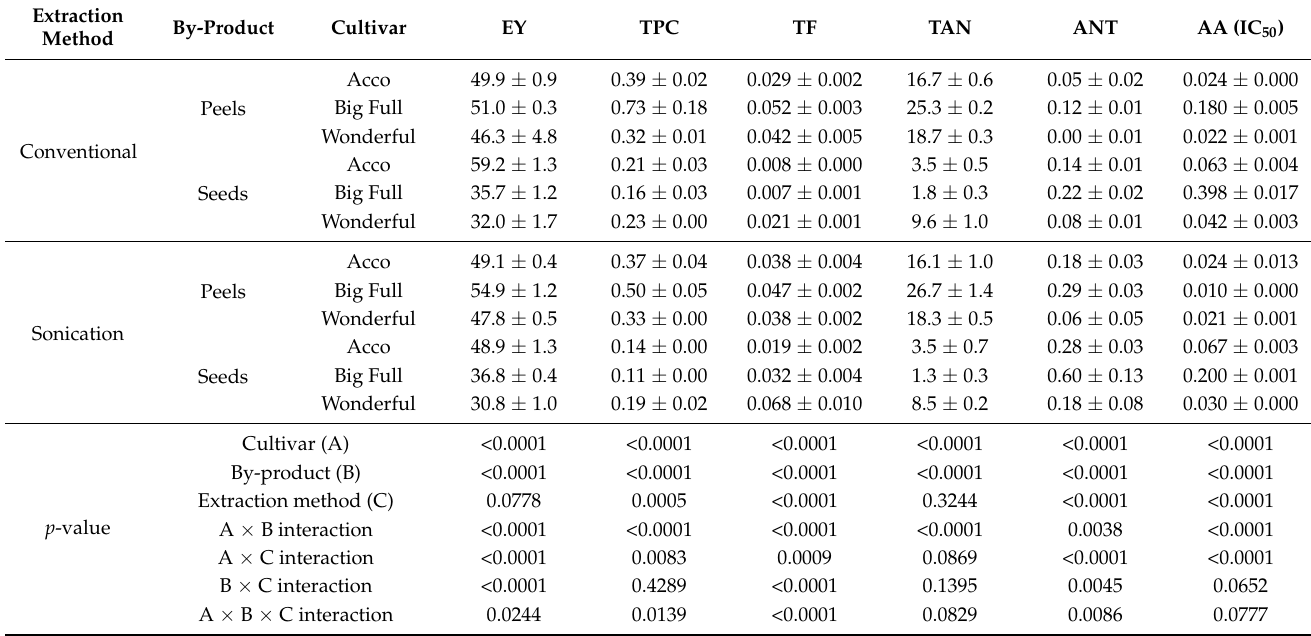
Table 2. Extraction yield (EY, %, db), total phenolic compounds (TPC, mg GAE/mg extract), total flavonoids (TF, mg CATE/mg extract), tannins (TAN, % w / w , db), anthocyanins (ANT, µ g C3G/mg, db), and antioxidant activity (AA expressed in terms of IC 50 , mg/mL, db) of the peels and seeds of three pomegranate cultivars (Acco, Big Full, Wonderful) according to extraction method (conventional vs.